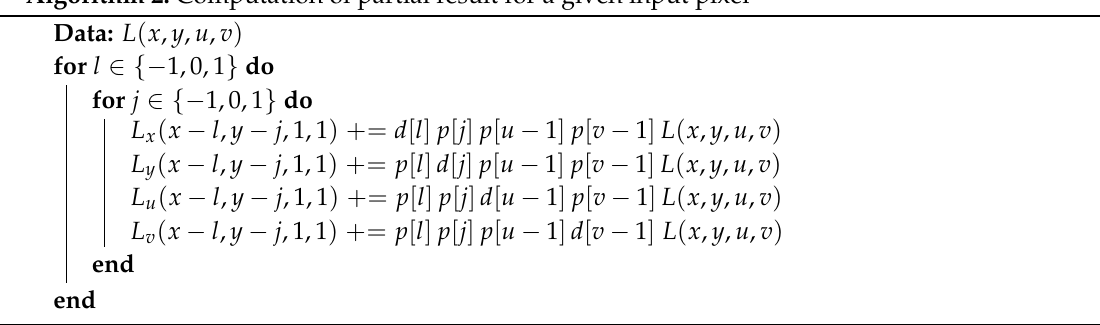
Algorithm 2: Computation of partial result for a given input